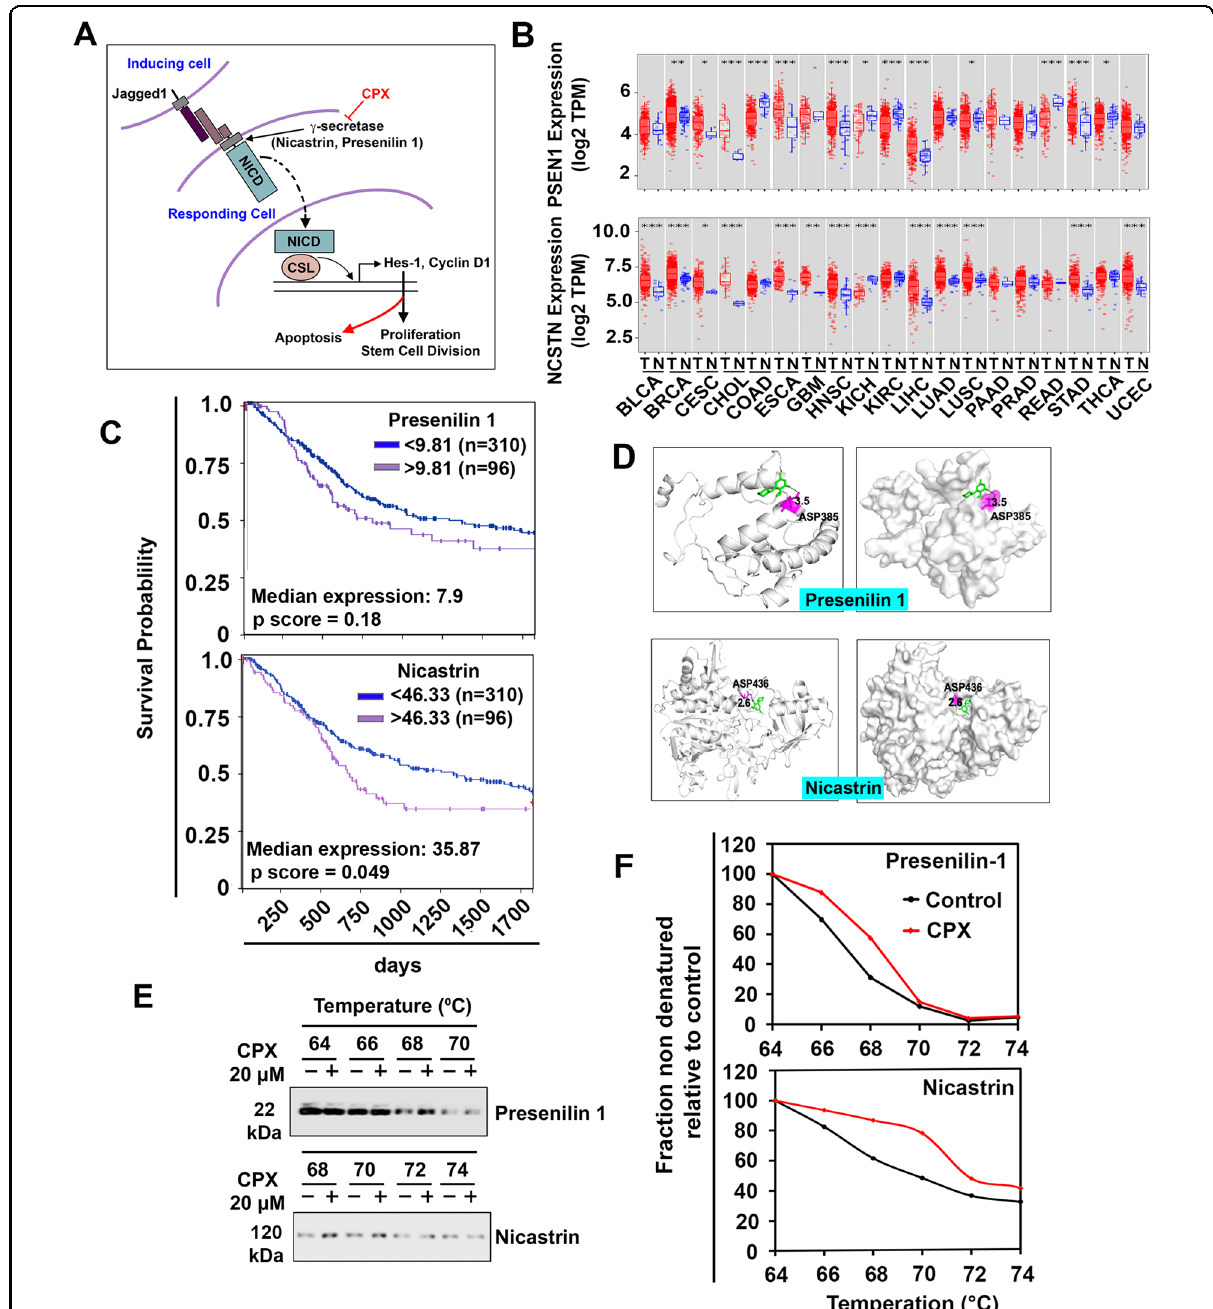
Fig. 7 CPX targets γ -secretase complex proteins Presenilin 1 and Nicastrin. A Schematic representation showing the Notch signaling pathway. CPX targets γ -secretase target proteins Presenilin 1 and Nicastrin in bladder cancer cells. B mRNA expression of Presenilin 1 and Nicastrin in different cancer patients in the Cancer Genome Atlas database, extracted from Timer 2.0. (Bladder Urothelial Carcinoma [BLCA], Breast invasive carcinoma [BRCA], Cervical squamous cell carcinoma and endocervical adenocarcinoma [CESC], Colon Adenocarcinoma [COAD], Esophageal Squamous Cell Carcinoma [ESCA], Glioblastoma multiforme [GBM], Head and Neck squamous cell carcinoma [HNSC], Kidney renal clear cell carcinoma [KIRC], Liver hepatocellular carcinoma [LIHC], Lung adenocarcinoma [LUAD], Lung squamous cell carcinoma [LUSC], Pancreatic adenocarcinoma [PAAD], Prostate adenocarcinoma [PRAD], Rectum adenocarcinoma [READ], Stomach adenocarcinoma [STAD], Thyroid carcinoma [THEA], Uterine Corpus Endometrial Carcinoma [UCEC]). C Kaplan – Meier survival analysis showed that higher levels of Presenilin 1 or Nicastrin expression ( p <0.05) were signi fi cantly associated with poor overall survival in patients with bladder cancer. D The molecular docking analysis predicted the binding of CPX in the protein cavity of Presenilin 1 and Nicastrin. AutoDock Vina software program was used for molecular docking. E Cellular thermal shift assay (CETSA). T24 cell lysates were treated with CPX and subjected to differential temperature treatment for 3mins and evaluated using western blot analyses. CPX protected Presenilin 1 and Nicastrin against thermal degradation, suggesting the active metabolite of CPX-POM interacts with these proteins. F Cumulative results from the densitometric evaluation of CETSA assay. Of fi cial journal of the Cell Death Differentiation